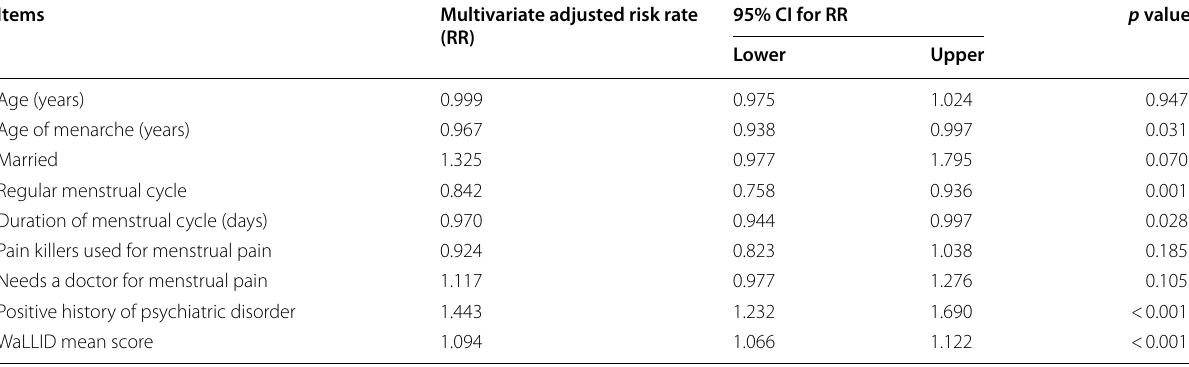
Dependent variable: PHQ-9 mean score. Estimating method: Maximum likelihood with gamma link RR Risk rate nearly the same interpretation of odds ratio, if not the = =